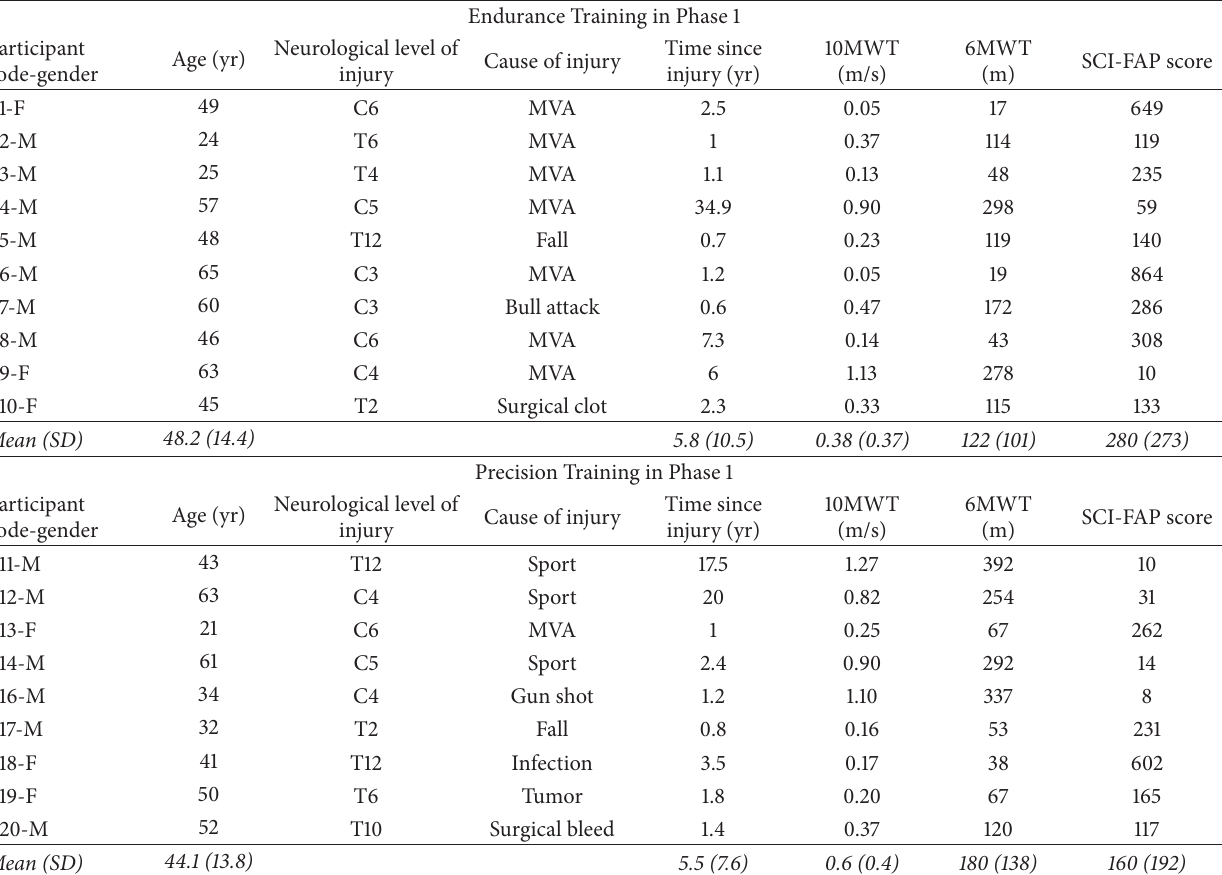
Table 1: Participant